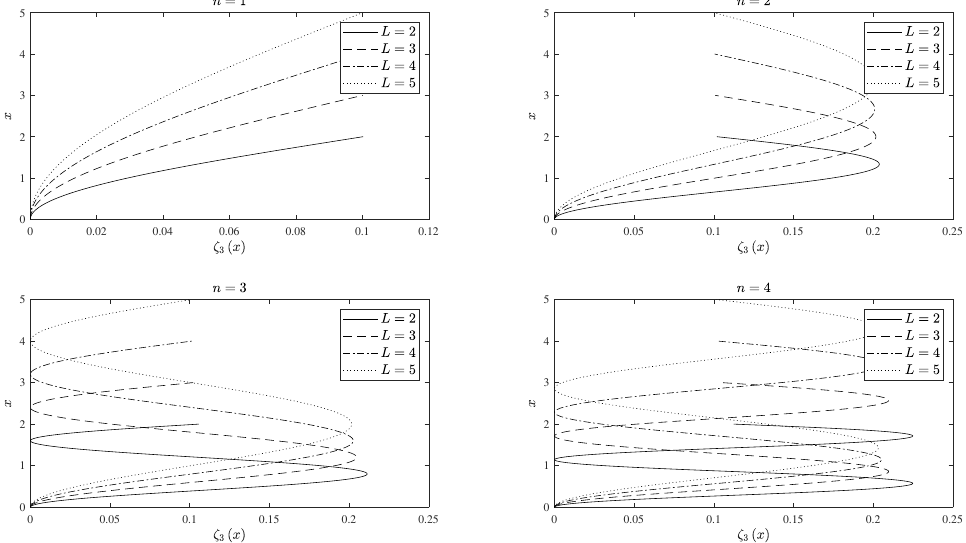
Figure 9. Different mode shapes of the buckled elastic cantilever beam for the four lowest buckling forces, n = 1, . . . ,4, as functions of the length L of the beam. The indeterminate constant is set as b =